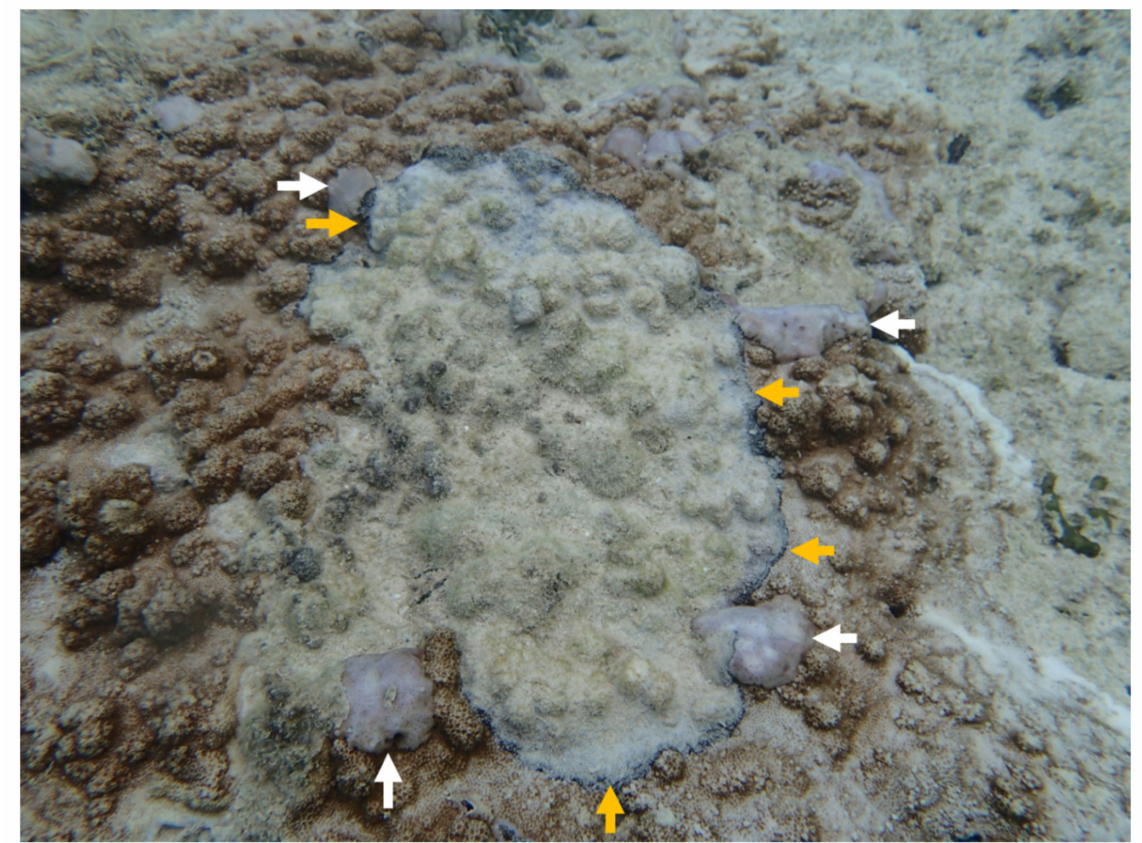
Figure 10. Observations of BBD (yellow arrow) and GA (white arrow) on the same colony of encrusting Montipora in site S1 in October 2017. Photograph: Rocktim Ramen